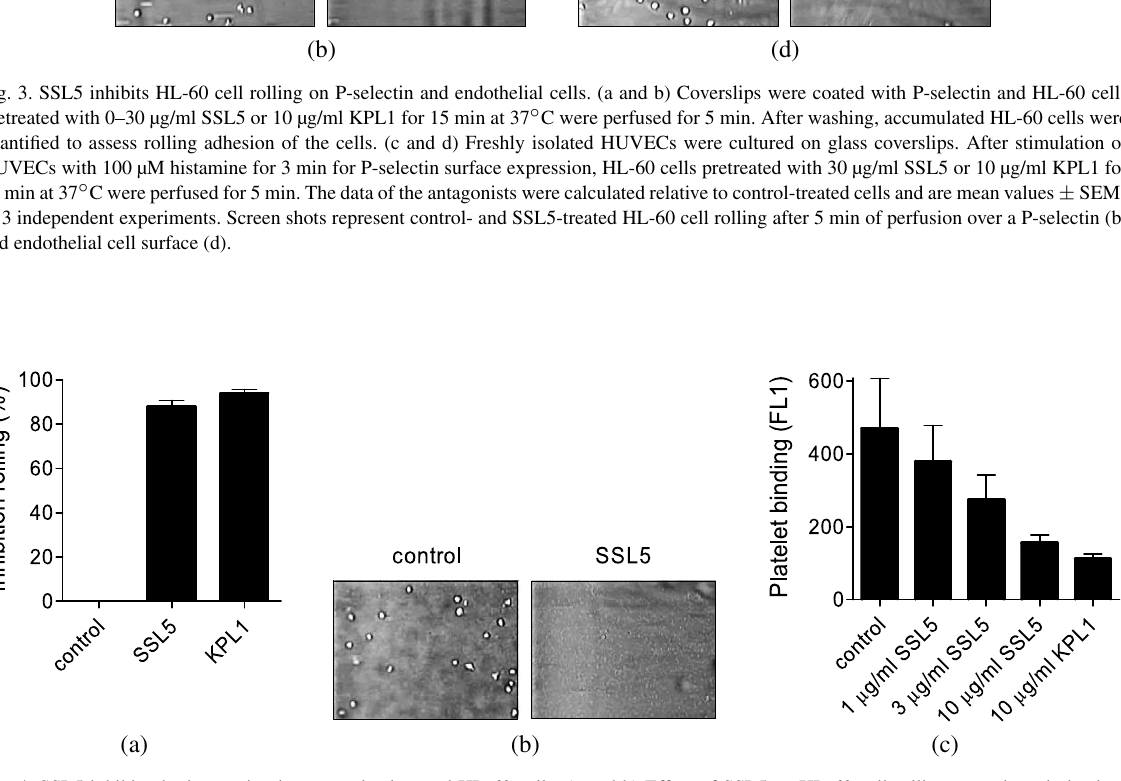
Fig. 4. SSL5 inhibits the interaction between platelets and HL-60 cells. (a and b) Effect of SSL5 on HL-60 cell rolling on activated platelets. An activated platelet-coated surface was generated by perfusing platelets with erythrocytes over a HUVEC-derived ECM surface. After washing, HL-60 cells treated with 30 µg/ml SSL5 or 10 µg/ml KPL1 were immediately perfused for 5 min. The data of the antagonists were calculated relative to control-treated cells and are mean values ± SEMs of 3 independent experiments. (b) Screenshots represent control- and SSL5-treated HL-60 cell rolling after 5 min of perfusion over an activated platelet surface. (c) HL-60 cells were incubated with 0–10 µg/ml SSL5 or 10 µg/ml KPL1 for 15 min. After washing, binding of calcein-labeled platelets to HL-60 cells was examined after a 10 min incubation by flow cytometry. Data represent mean fluorescence values ± SEM of four independent